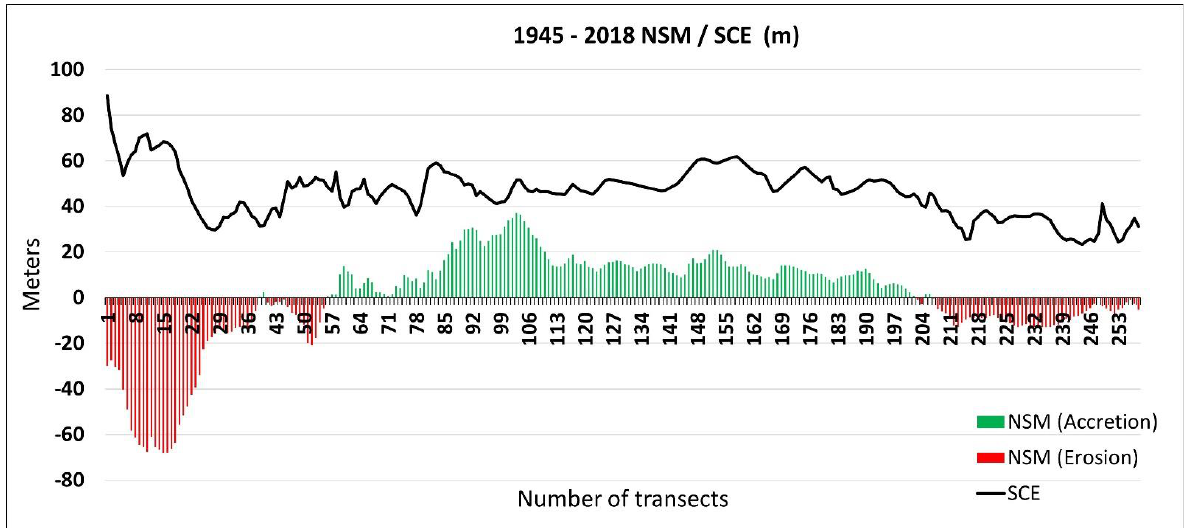
Figure 15. NSM rates showing erosion (red color) and accretion (green color) in conjunction with the SCE rates (black line) for the 1945 – 2021 period.